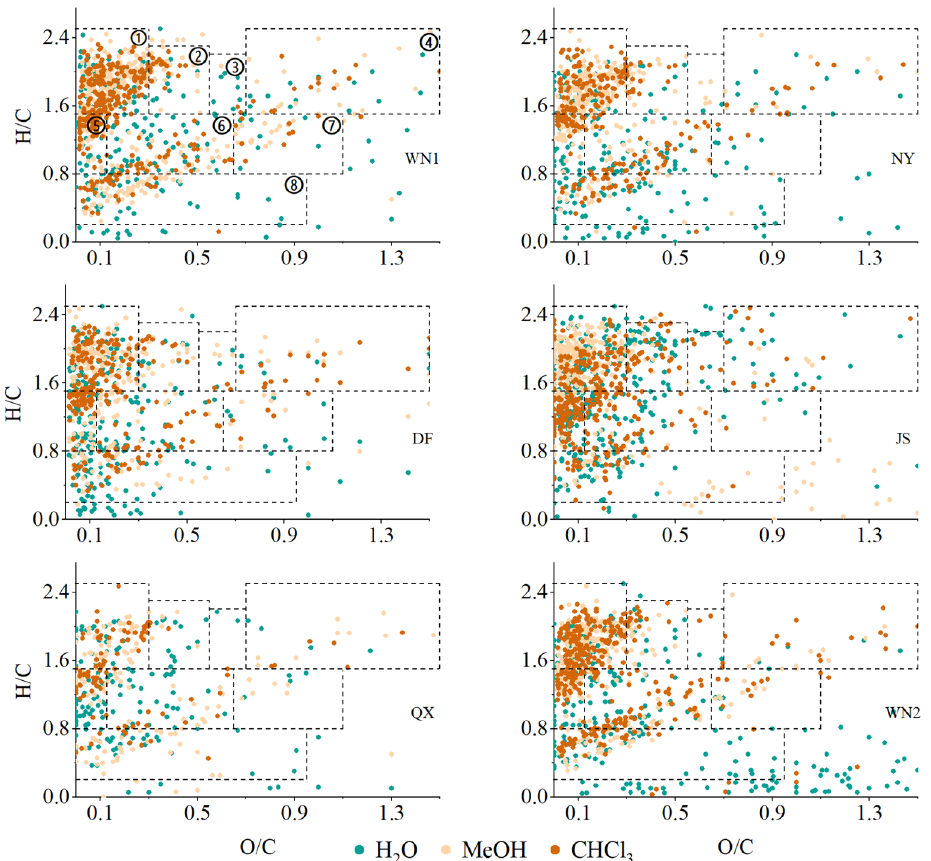
Figure 4. The chemical composition of SOM compounds of different soil samples. Colors indicate different extracts. Different numbers on dotted box in WN1 represent different compounds that are appropriate for all the figures: ① Lipids, ② Proteins, ③ Amino Sugars, ④ Carbohydrates, ⑤ Unsaturated hydrocarbons, ⑥ Lignin, ⑦ Tannins, ⑧ Condensed